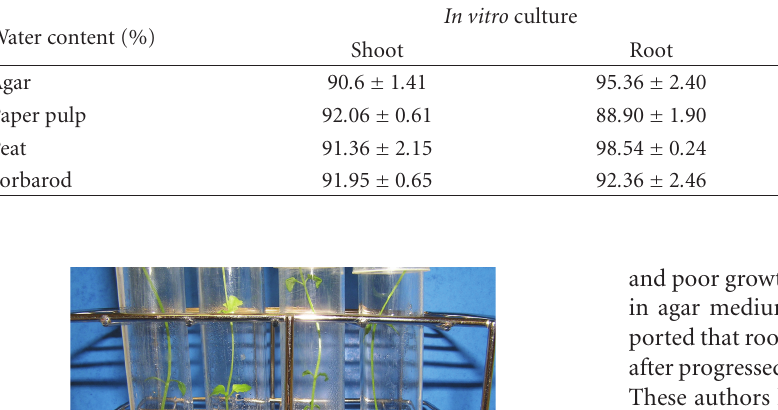
Figure 2: Dry mass of nemesia after 25 days of in vitro culture (a) and after 21 days of acclimatization (b). SFM: shoot fresh mass, RFM: root fresh mass, SDM: shoot dry mass, and RDM: root dry mass. Data are mean ± se, n = 24. Table 1: Nemesia water content (%) after 25 days of in vitro culture and after 21 days of acclimatization in greenhouse conditions.